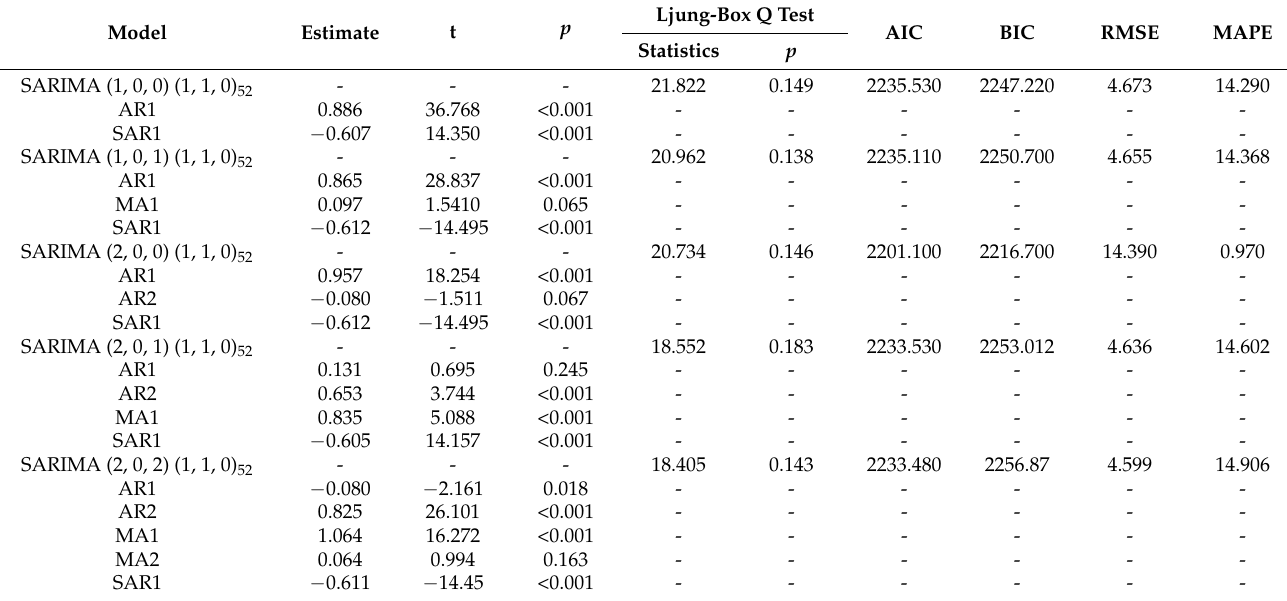
Table 3. Comparison of candidate SARIMA models.